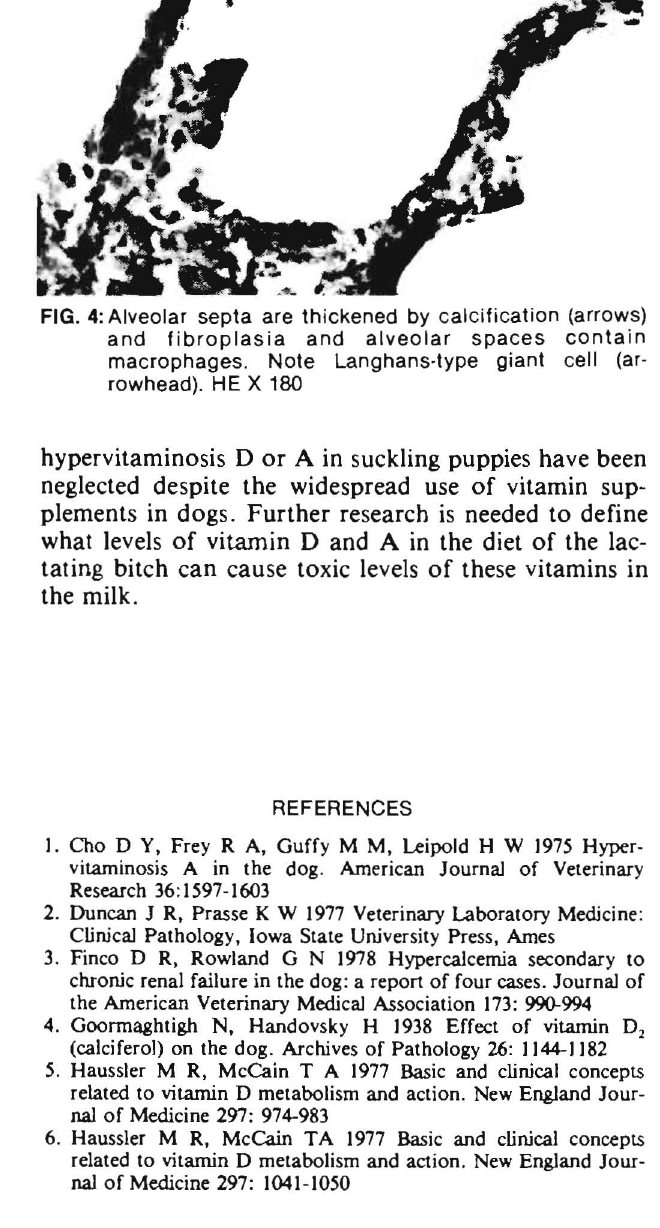
FIG. 3:Thoracic aorta with areas of mineralized elastic fibres (arrows). HE X 70